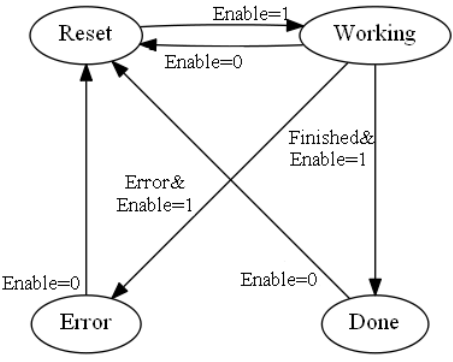
Figure 9. The micro state machine used by all Stateful primitives.